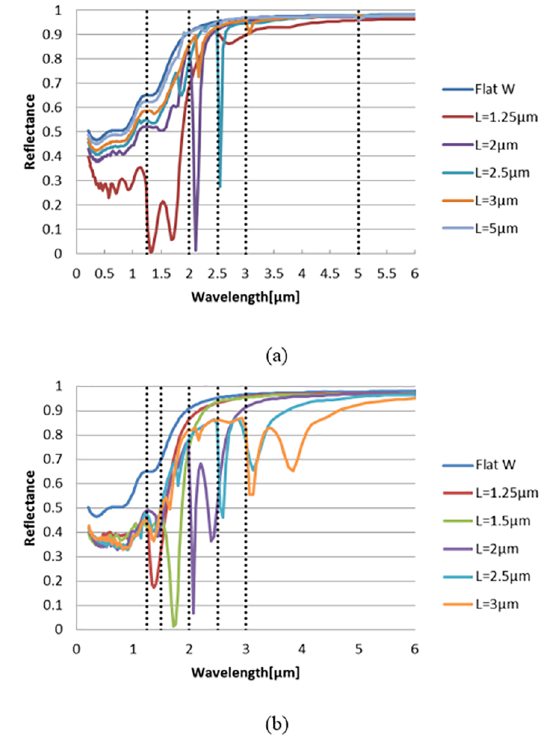
Figure 4. Reflectance spectrum for different periods (L) with (a) A=1µm (b) A=L-0.6µm and depth